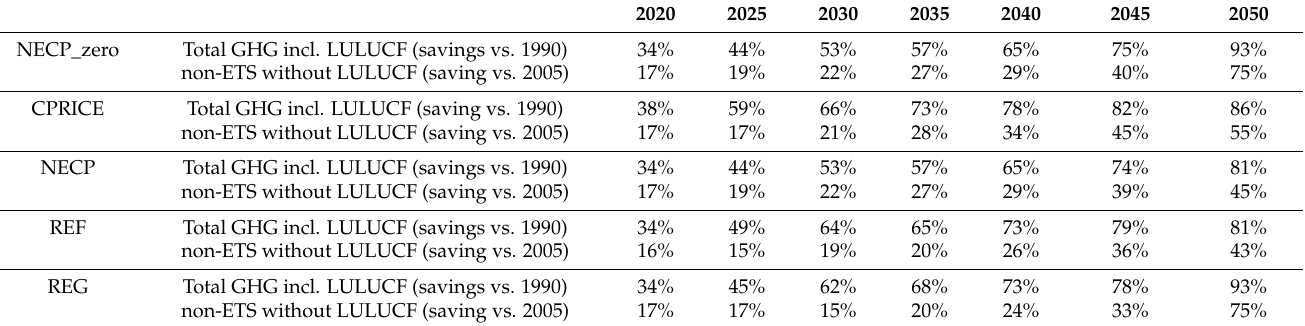
Table 7. GHG emission savings compared to 1990 and 2005